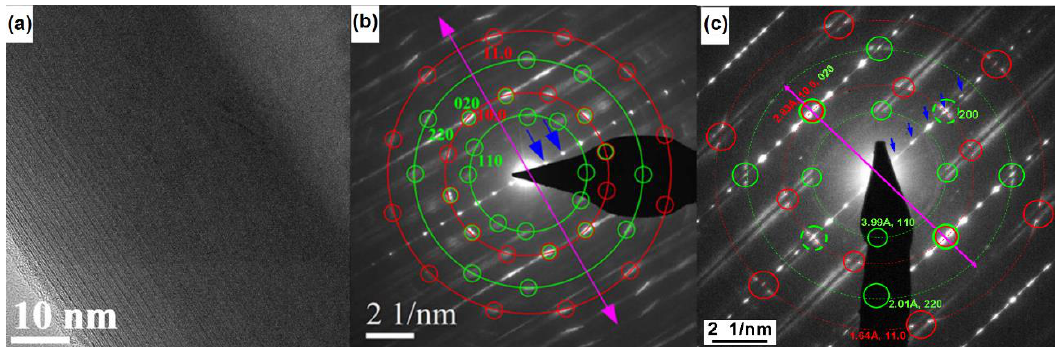
Figure 3. ( a ) High resolution transmission electron microscope (HRTEM) image of a Sr x La 1 − x S-TaS 2 (Sr 60 at %) tube. ( b ) Selected area electron di ff raction (SAED) showing the orientation relationship between the Sr x La 1 − x S layers (green) and the TaS 2 layers (red). The tube axis is represented by the pink double arrow, and the basal reflections are marked with blue arrows (adopted from [27] courtesy of Dr. L.F. Deepak). ( c ) SAED of a LaS-TaS 2 nanotube (adopted from [24]) with the b -axis [10.0] || [020] parallel to the tube axis.